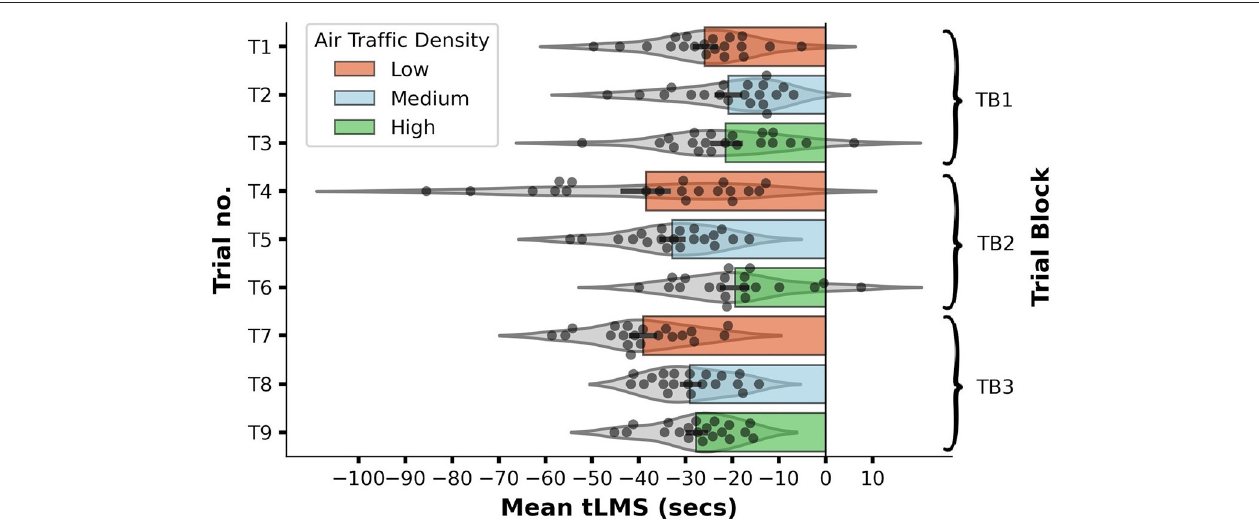
FIGURE 9 | Horizontal bar graph with violin plots showing the distribution of mean Air Traffic Conflict Detection Task (AT-CDT) time to loss of minimum separation (tLMS) values obtained from each participant on each test trial (T1–T9). Longer bars represent faster responses associated with quicker detections of conflicts. Each error bar represents ± 1 SE . Zero on the x-axis marks the time-point at which a conflict event occurs. The violin plot overlaid on each bar represents the probability density function (PDF) of the data distribution on each trial. Each PDF was mirrored along the central horizontal axis of each bar. Data distribution on the fourth trial was platykurtic due to the presence of a few fast responders.